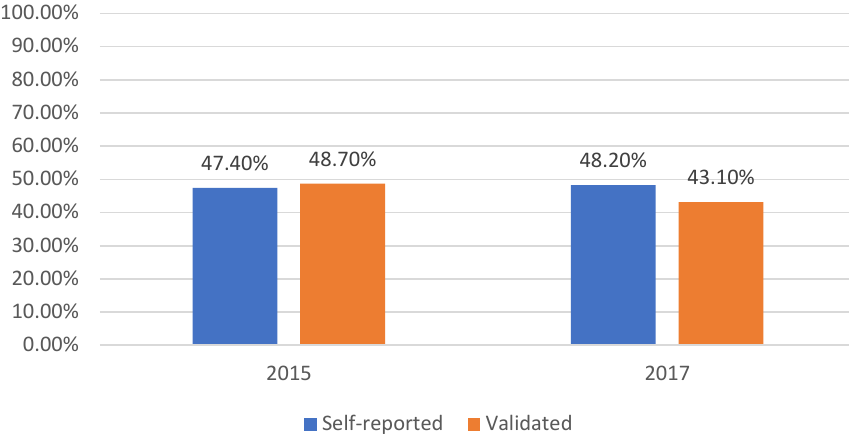
Figure 1. The British Election Study’s estimated 18–24-year-old turnout in the 2015 and 2017 general elections. Source: Prosser et al. [1].